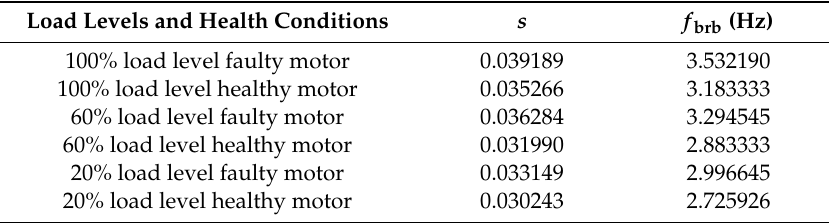
Figure 3. The three-phase current signals and their spectra of the healthy motor and faulty motor: ( a ) is the time-domain diagram of the three-phase current signals of the healthy motor, ( b ) is the spectrum of phase A of the healthy motor, ( c ) is the time-domain diagram of the three-phase current signals of the faulty motor, ( d ) is the spectrum of phase A of a faulty motor. Table 2. The result of slip and signature